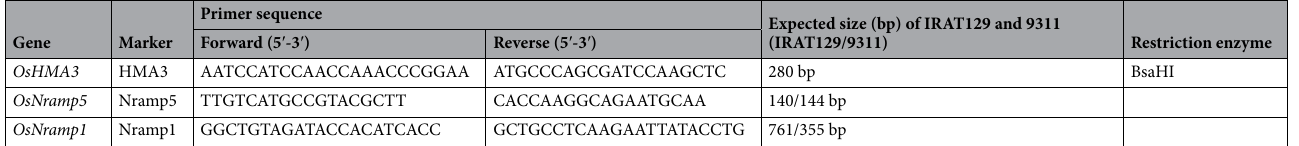
Table 2. Three developed intra-genic markers used to amplify Cd accumulating genes.